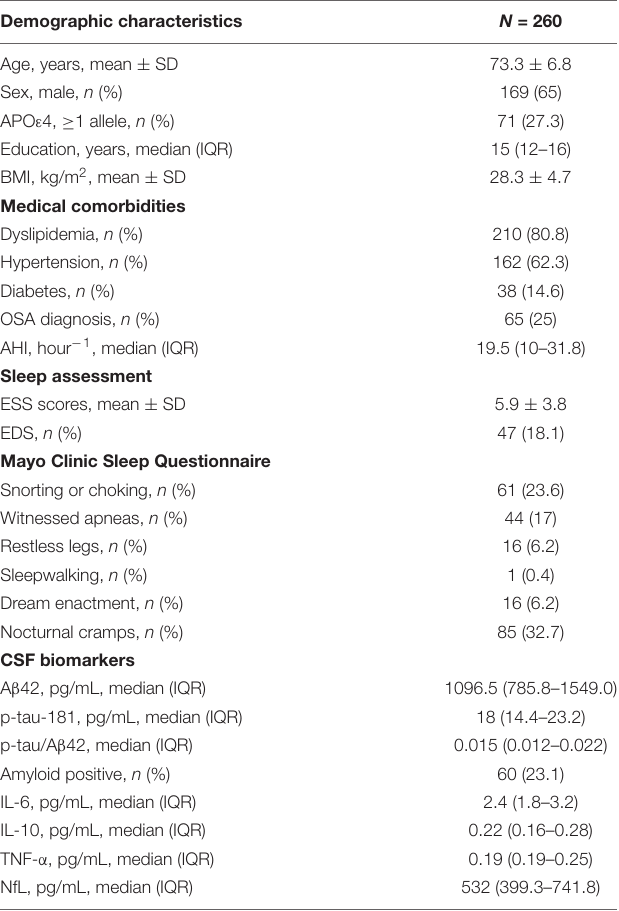
TABLE 1 | Demographic, clinical, and CSF biomarker characteristics. Demographic